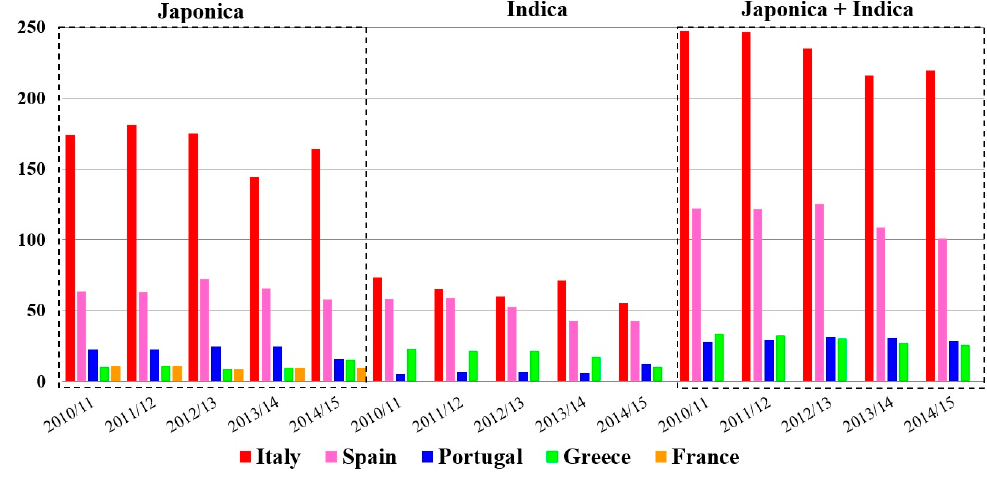
Figure 3. Rice varieties areas in the EU member states [37].